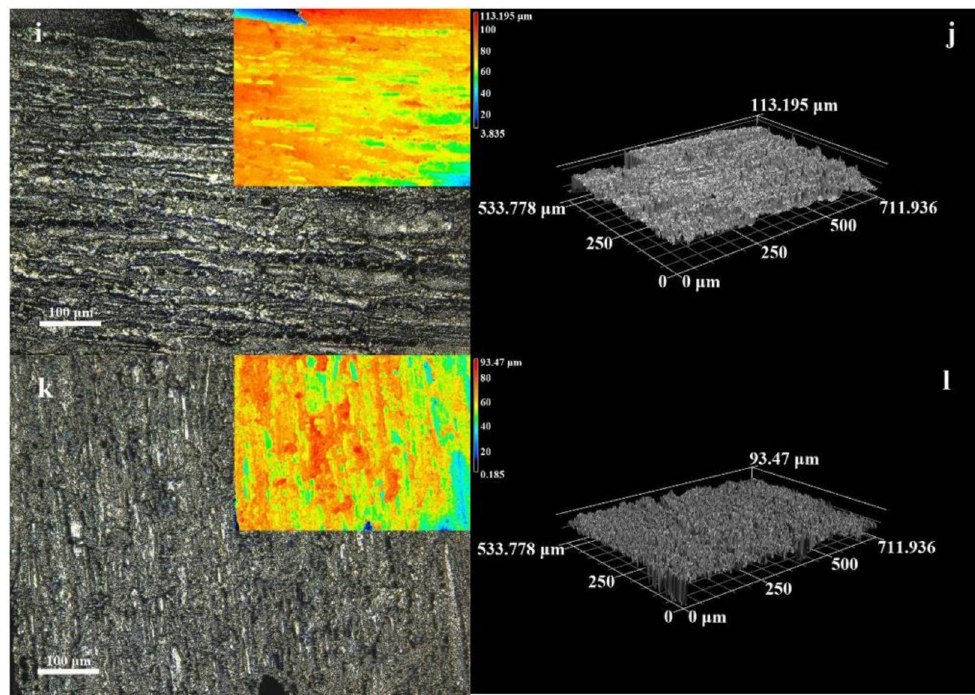
Figure 5. The morphology of the first electroless Ni wood surface by laser copolymerization micro- scope was 200 × (( a , c , e , g , i , k ) followed by the morphology of the wood surface after electroless Ni for 1, 5, 10, 15, 20, 25 min. The embedded figure is the well depth figure; ( b , d , f , h , j , l ) is 3D figure of electroless time 1, 5, 10, 15, 20, 25 min, respectively).